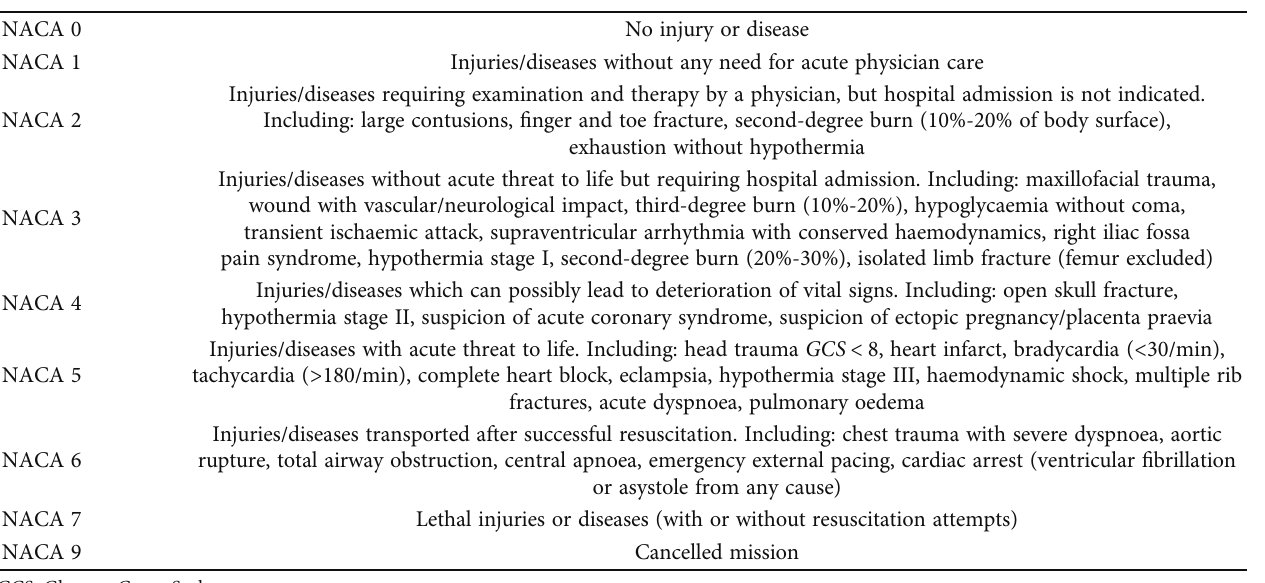
Table 1: Modi fi ed National Advisory Committee for Aeronautics (NACA) score used in the State of Valais. NACA 0 No injury or disease NACA 1 Injuries/diseases without any need for acute physician care Injuries/diseases requiring examination and therapy by a physician, but hospital admission is not indicated. NACA 2 Including: large contusions, fi nger and toe fracture, second-degree burn (10%-20% of body surface), exhaustion without hypothermia